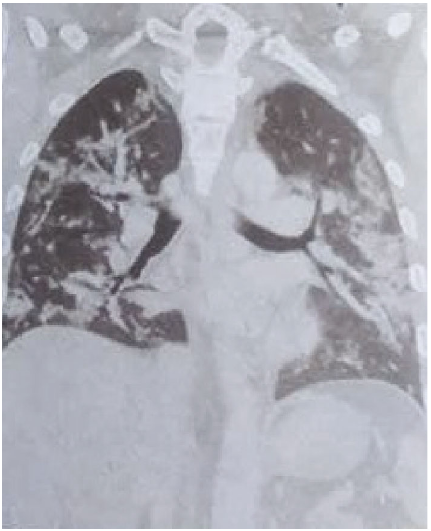
Figure 1: HRCT of chest showing multifocal consolidation with ground glass opacities, interlobular septal thickening, and fi brotic bands in the lungs.